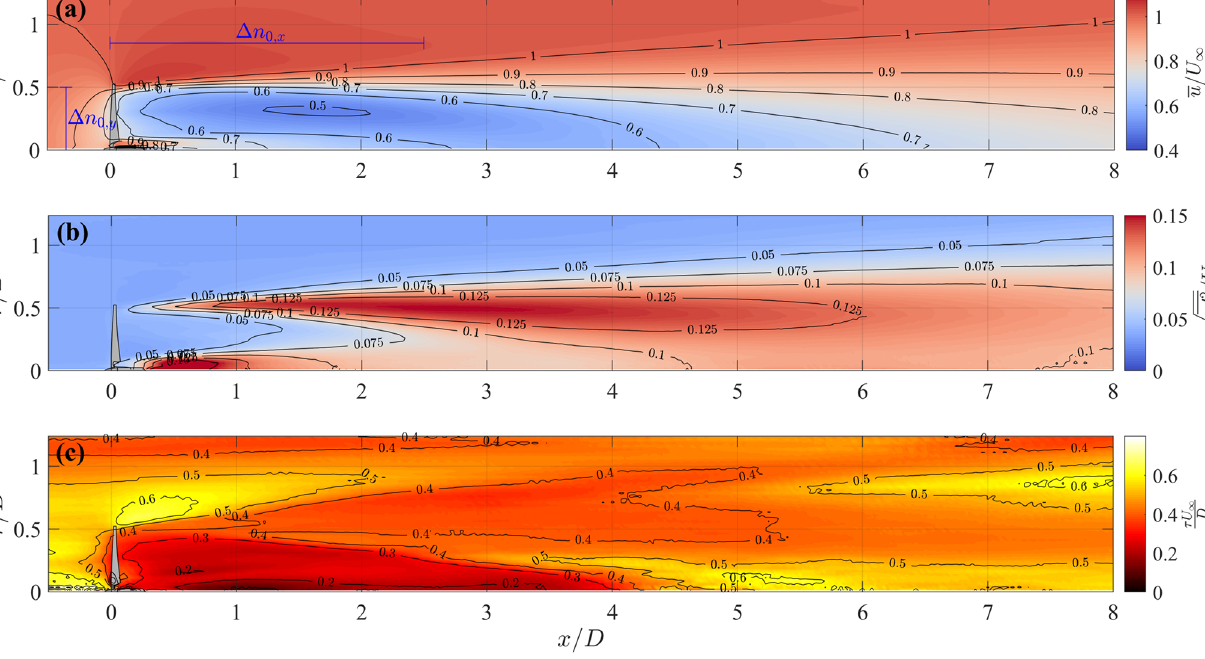
Figure 8. Azimuthally averaged statistics of the LES streamwise velocity field. (a) Mean value, (b) standard deviation, and (c) integral